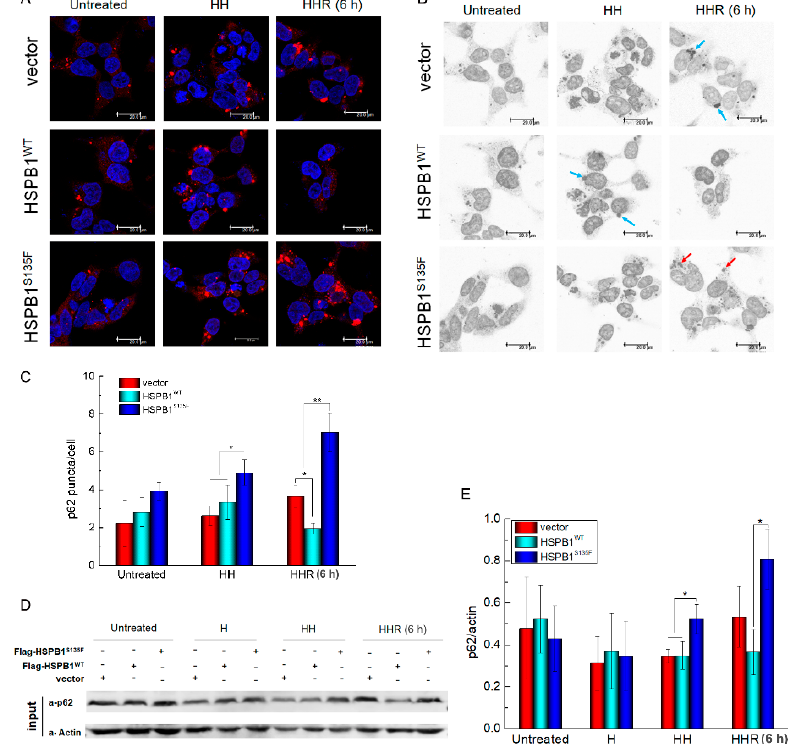
Figure 5. HSPB1 S135F prevents clearance of p62 punctuate inclusions. ( A ) Immunofluorescence imaging of p62 punctuate inclusions in HEK293T cells treated with heat shock or MG132. ( B ) Intracellular distribution of p62 punctuate inclusions in HEK293T cells. Perinuclear punctuate inclusions are shown by blue arrows; whereas cytoplasmic ones indicated by red arrows. Scale bars: 20 µm. ( C ) Average number of p62 punctuate inclusions per cell calculated by ImageJ; ** , p < 0.01. ( D , E ) Western blot of p62 expression in HEK293T cells; * , p < 0.05.